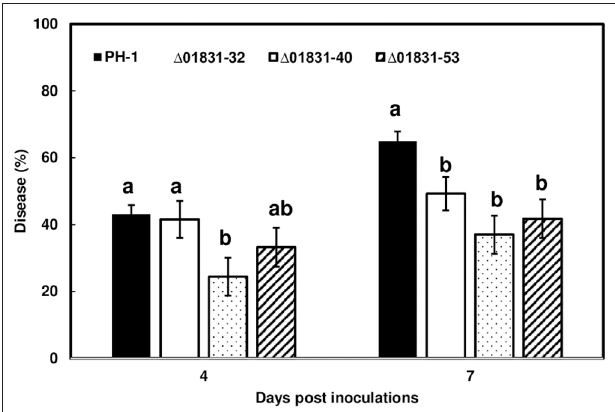
FIGURE 5 | Reduction of initial infection caused by 1 01831mutants on wheat heads. Inoculations were performed by immersing whole heads of wheat cv. Alsen in suspensions of F. graminearum PH-1 and three 1 01831 mutants (32, 40, and 53), respectively (5 × 10 4 conidia/mL). FHB was scored as the percentage of florets with visual symptoms at 4- and 7-days post inoculation (dpi). Bars represent the average percentages and standard error of 20 inoculated heads with each strain. The statistical analyses were performed for each time point. Letters indicate significance level at the P < 0.05 level by one-way analysis of variance (ANOVA) and Dunnett’s test using JMP.